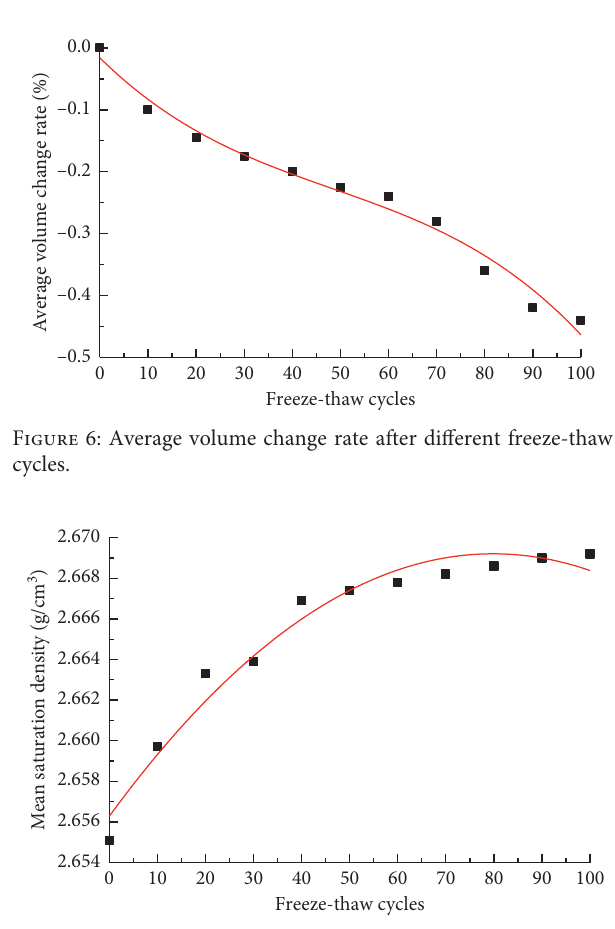
Figure 7: Changes in average saturation density under different freeze-thaw